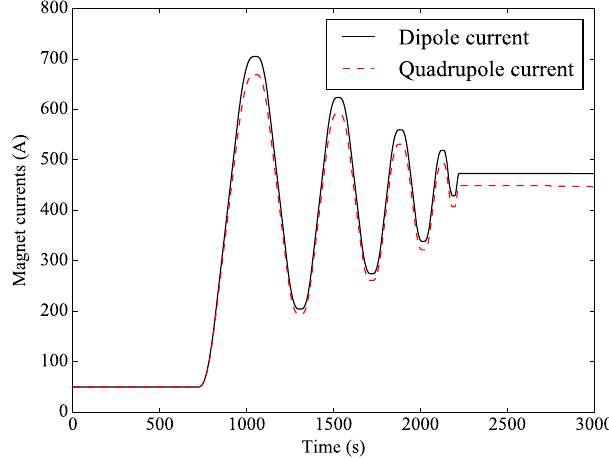
FIG. 5. Demagnetization magnetic cycle: RHIC superconduct- ing dipole and quadrupole magnet currents are ramped up and down several times, with intermediate dipole current points at [50, 700, 200, 625, 275, 560, 340, 520, 430 A], before being held constant at the operating currents for beam